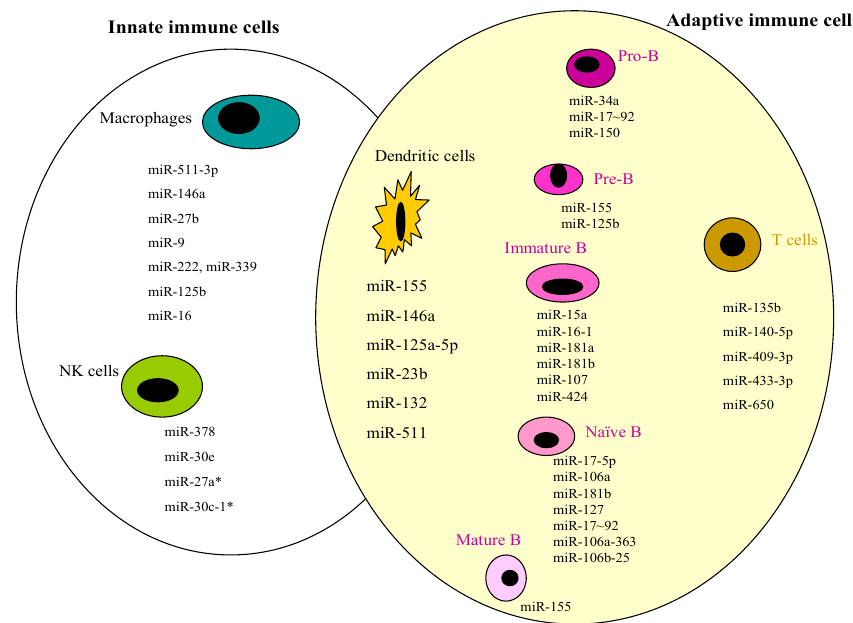
Figure 1. Involvement of miRNAs in immune